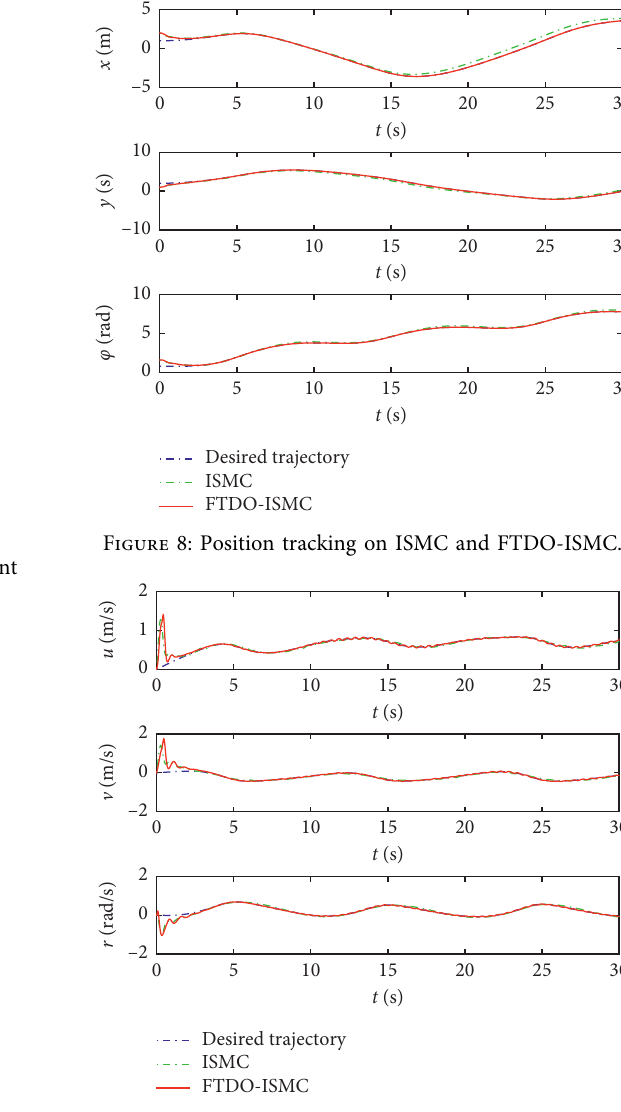
Figure 6: Control input on ISMC.